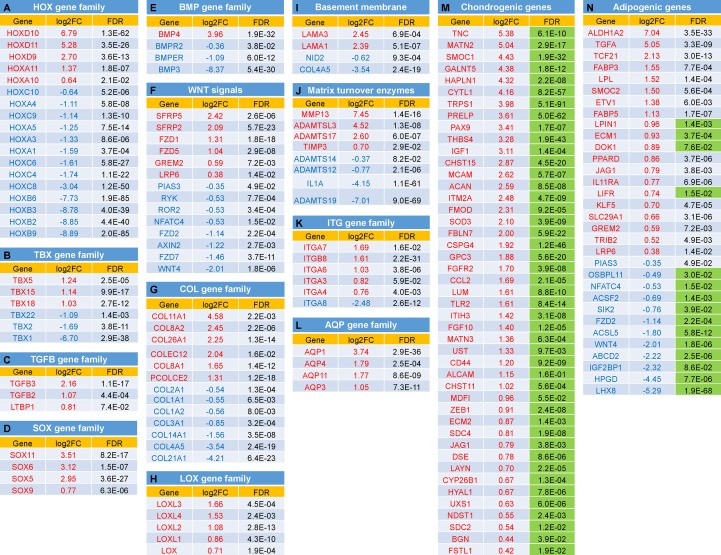
Expression changes between IPFSCs and ScASCs for selected groups of genes with function in chondrogenesis and/or adipogenesis: (A) Homeobox (HOX) gene family; (B) T (the brachyury gene)-box (TBX) gene family; (C) TGFβ (TGFB) gene family (D) SOX gene family; (E) Bone morphogenetic protein (BMP) gene family; (F) Wingless/integrase-1 (WNT) gene signals; (G) Collagen (COL) gene family; (H) Lysyl oxidase (LOX) gene family; (I) Genes coding for Basement membrane proteins; (J) Genes coding Matrix turnover enzymes; (K) Integrin (ITG) gene family; (L) Aquaporin (AQP) gene family; (M) Chondrogenic-related genes; and (N) Adipogenic-related genes. Green shaded FDR indicates favorable effect of the gene on chondrogenesis (M) or adipogenesis (N). A positive value in log2FC means higher expression in IPFSCs (in red), and a negative value means higher expression in ScASCs (in blue). Orange shaded FDR: > 0.05.